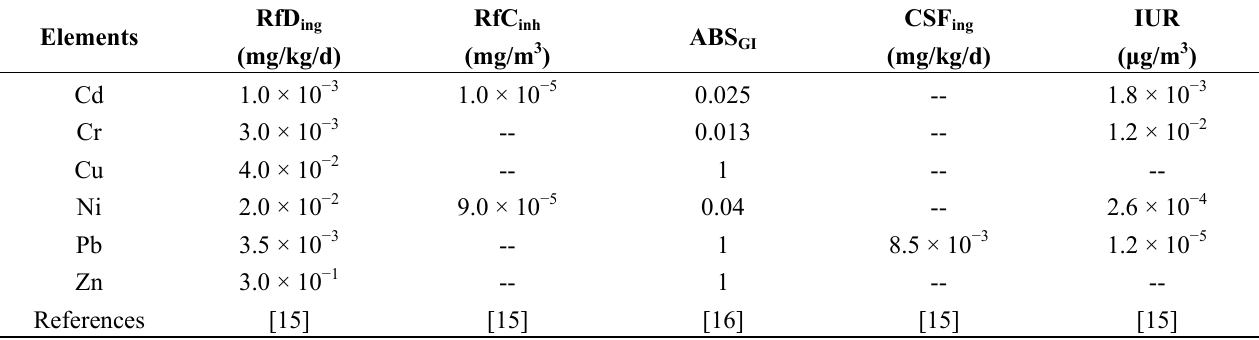
Table 2. Toxicological parameters for different heavy metals of health risk